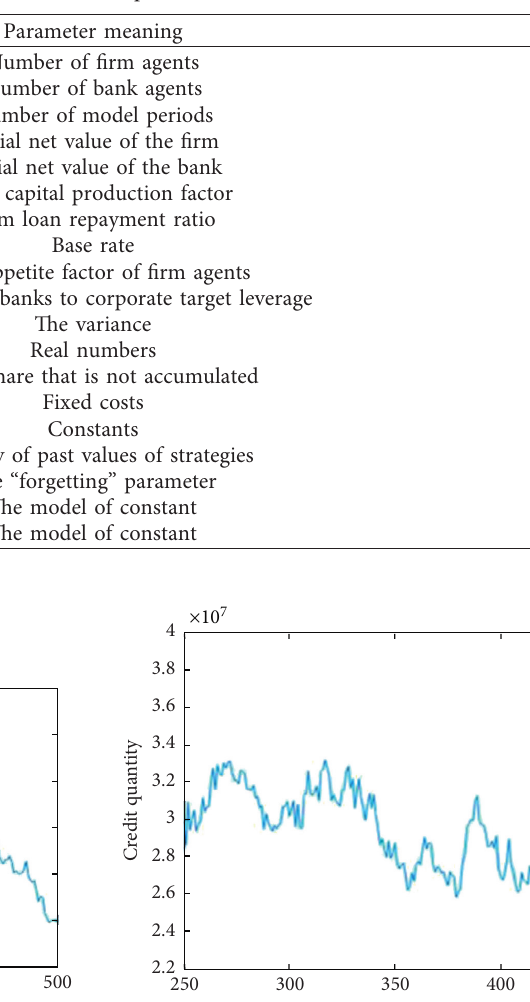
Figure 1: Evolutionary characteristics of corporate default rate and bank insolvency rate with Table 1: Model baseline parameter values.